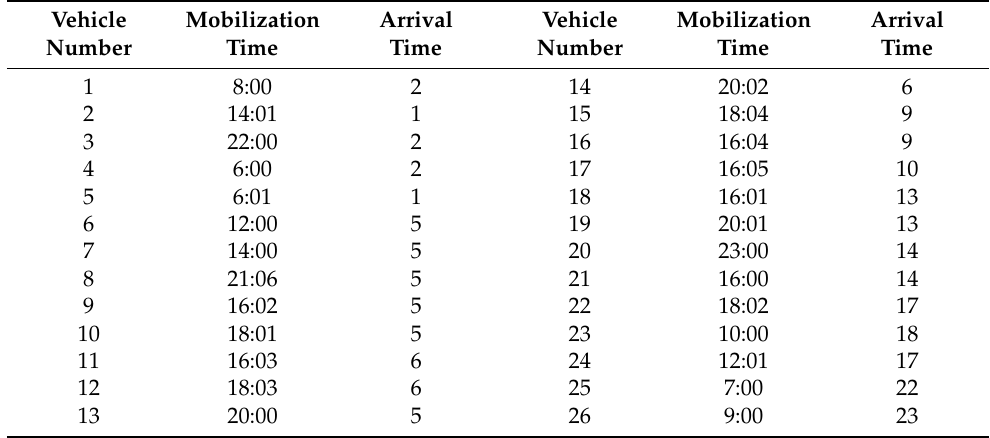
Table 6. Set of one of the optimal